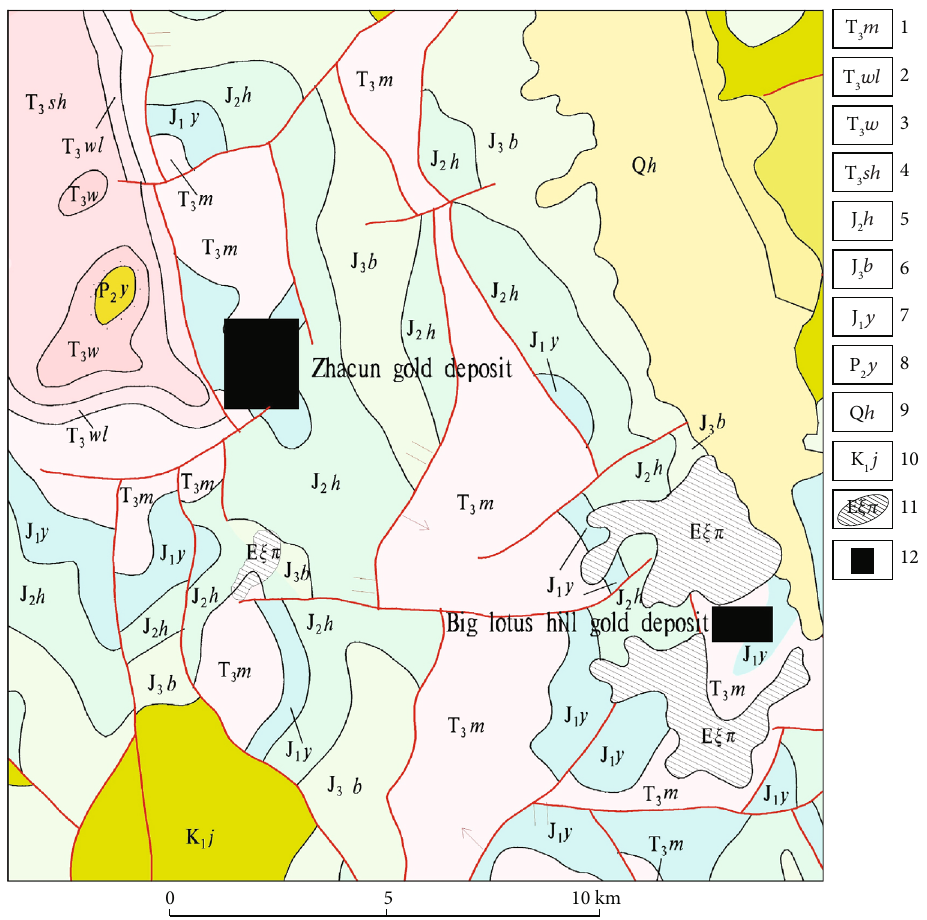
Figure 1: Distribution of alkaline rock mass around Zhacun goldmine. 1: Triassic Maichuqing Formation; 2: Triassic Waluba Formation; 3: Triassic Waigucun Formation; 4: Triassic Sanhedong Formation; 5: Permian Huakaizuo Formation; 6: Permian Bazhulu Formation; 7: Cretaceous Yangjiang Formation; 8: Permian Yangbazhai Formation; 9: Holocene series; 10: Cretaceous Jingxing Formation; 11: alkaline porphyry mass; 12: ore deposit range. Table 1: Metallogenic epochs of Zhacun goldmine, Dalianhuashan goldmine, and Lianhuashan alkali-rich rock mass [34]. Ore deposit/mine area/rock